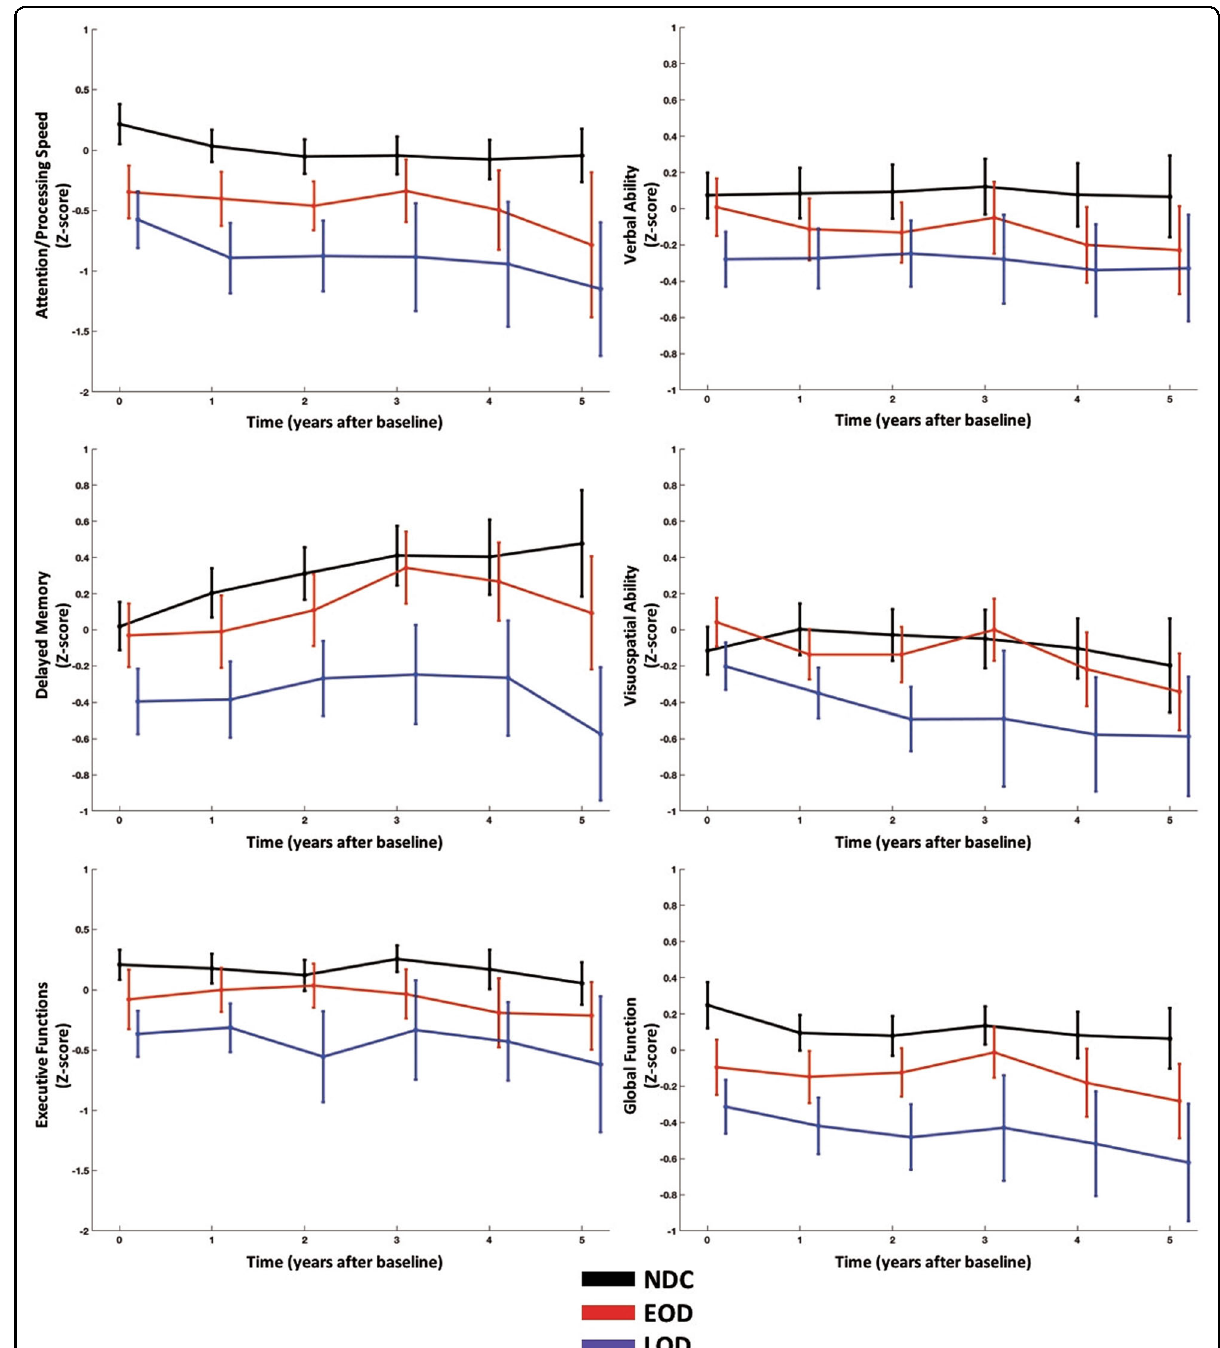
Fig. 2 Graph of cognitive trajectories comparing NDC vs. LOD vs. EOD. At baseline, the LOD group performed worse than NDC in all domains while all three groups differed in the attention/processing speed and global function domains (NDC > EOD > LOD). The LOD group declined more rapidly than both the NDC and EOD groups in the verbal ability and delayed memory